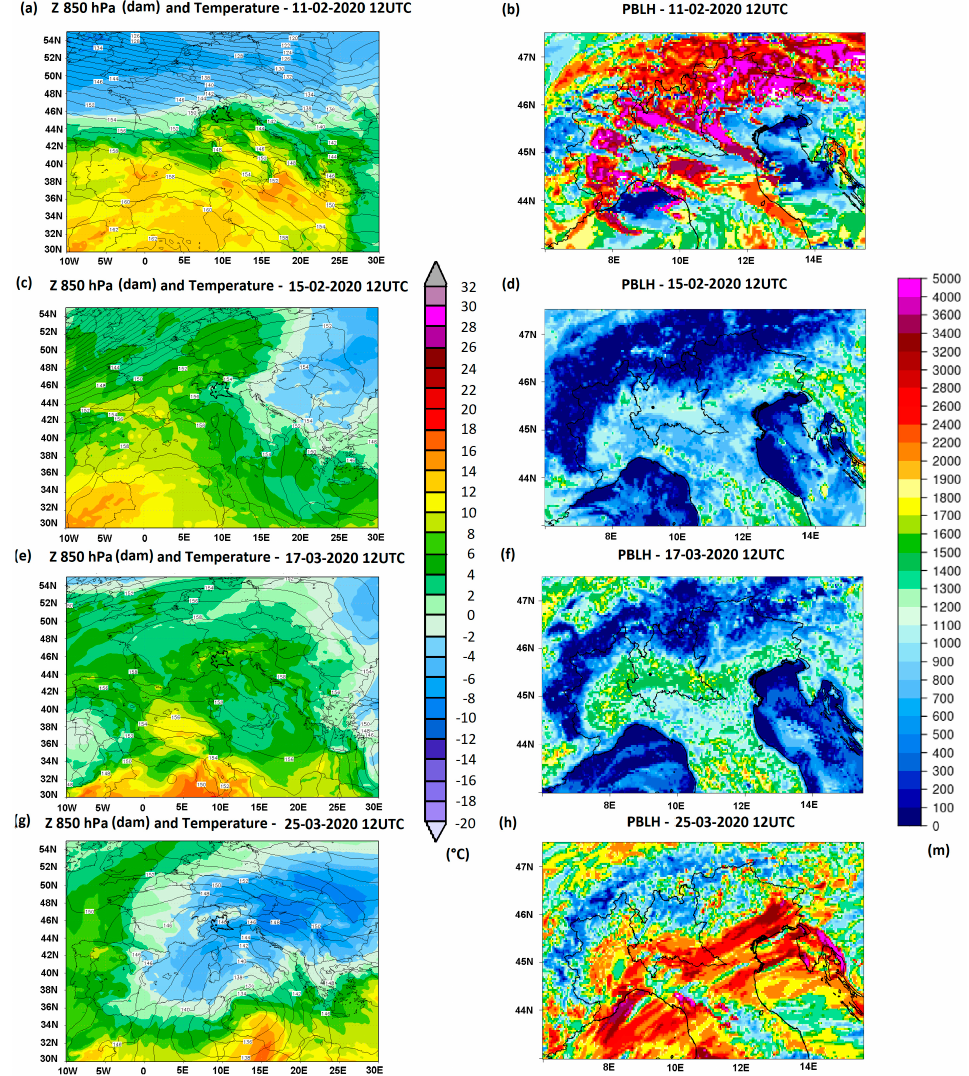
Figure 5. Maps of the geopotential height Z (dam) and temperature at the 850 hPa level ( a , c , e , g ) and of the planetary boundary layer (PBL) height ( b , d , f , h ) for the four more significant days in the analyzed period. In the left panels, the Global Forecast System (GFS) model output is reported; in the right panels, the WRF-ARW model is driven with GFS boundary conditions. The Lombardy borders and the point associated with the city of Milan have also been inserted in the maps to better identify the region of